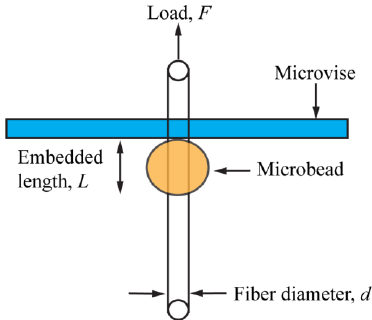
Figure 1. Schematic for the microbond test [31]. Reprinted with permission; 2010, VSP/Brill NV,